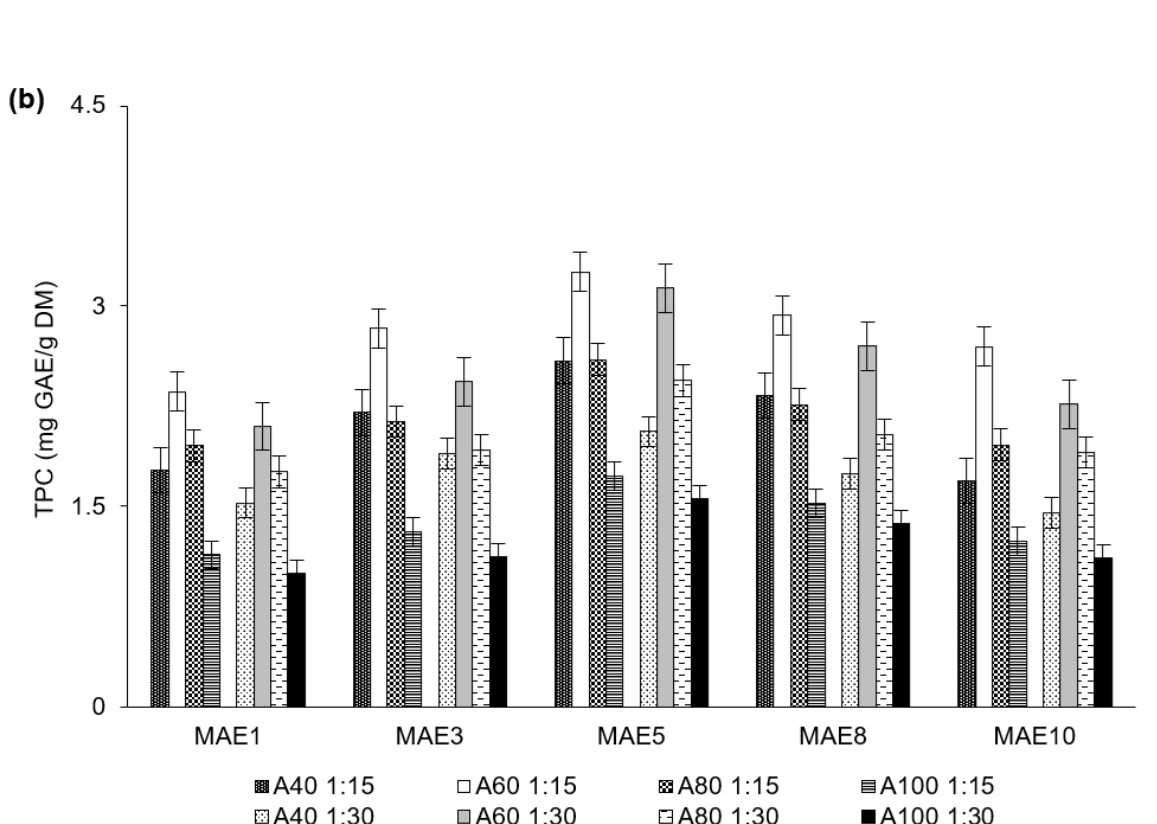
Figure 1. TPC that was extracted from distillery stillage with UAE ( a ) and MAE ( b ). In the abbre- viations used to refer to the series, the values after UAE and MAE indicate the extraction time; the values after A (acetone) show the solvent concentration; and finally, the solid-to-solvent ratio is given.